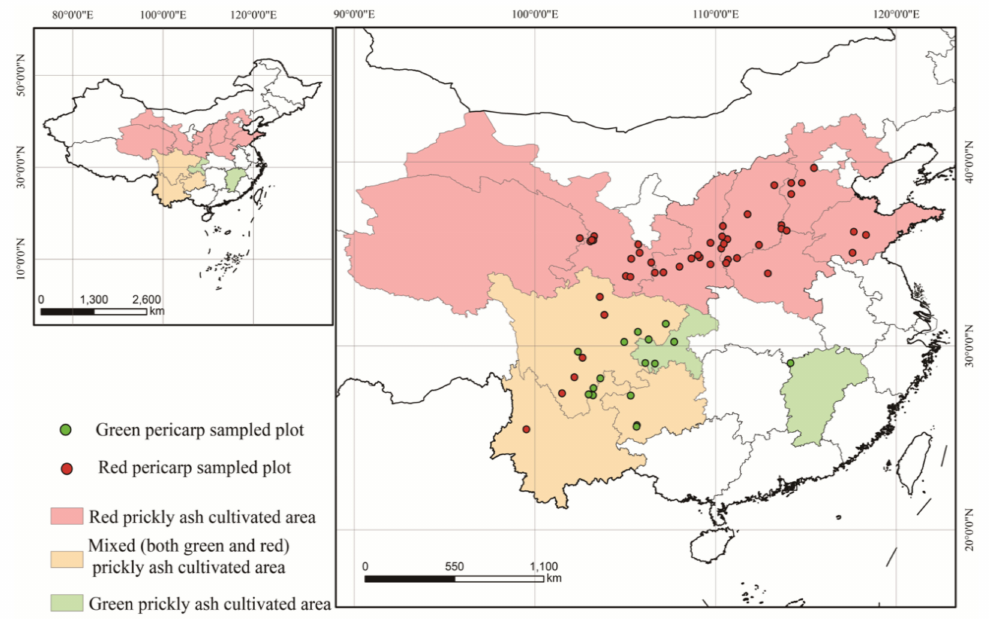
Figure 1. Sample origins for the 72 prickly ash